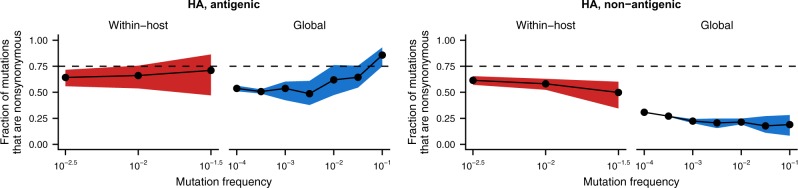
Mutations in antigenic sites of HA experience increased positive selection as viruses transmit and circulate between hosts. Fraction of within-host and global mutations that are nonsynonymous were calculated as described in Fig. 5 for a set of previously defined antigenic sites (Wolf et al. 2006). Dashed lines indicate the ∼75 per cent of de novo mutations that are expected to be nonsynonymous. The fraction of nonsynonymous mutations within hosts is shown as the mean and 95 per cent confidence interval of 100 bootstrap samples of the within-host viral populations. The fraction of nonsynonymous mutations in the global influenza population is shown as the mean, minimum, and maximum of the values calculated separately for the 2015–6, 2016–7, and 2017–8 H3N2 seasons.